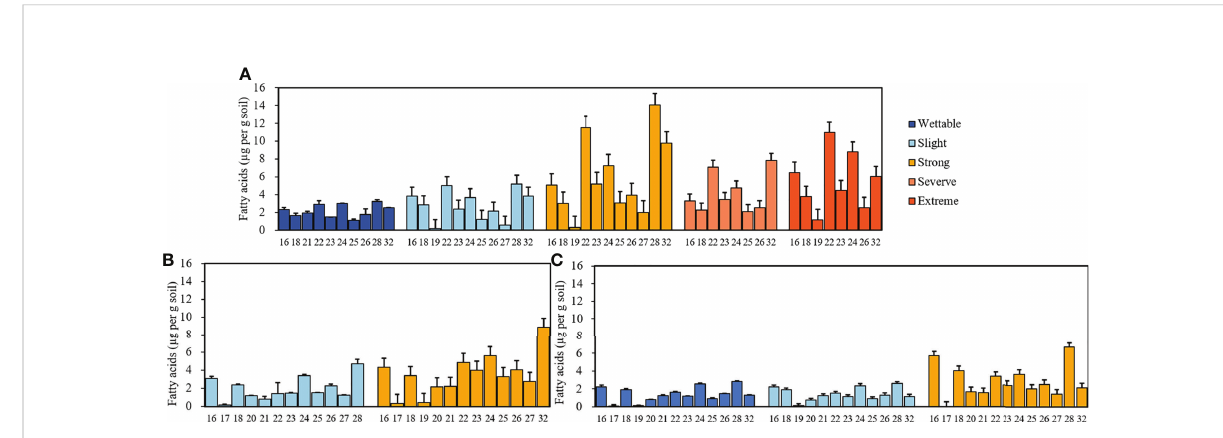
FIGURE 4 Relative concentrations of fatty acids with different carbon numbers beneath Pinus (A) , Robinia (B) , and Hippophae (C) (n=3).